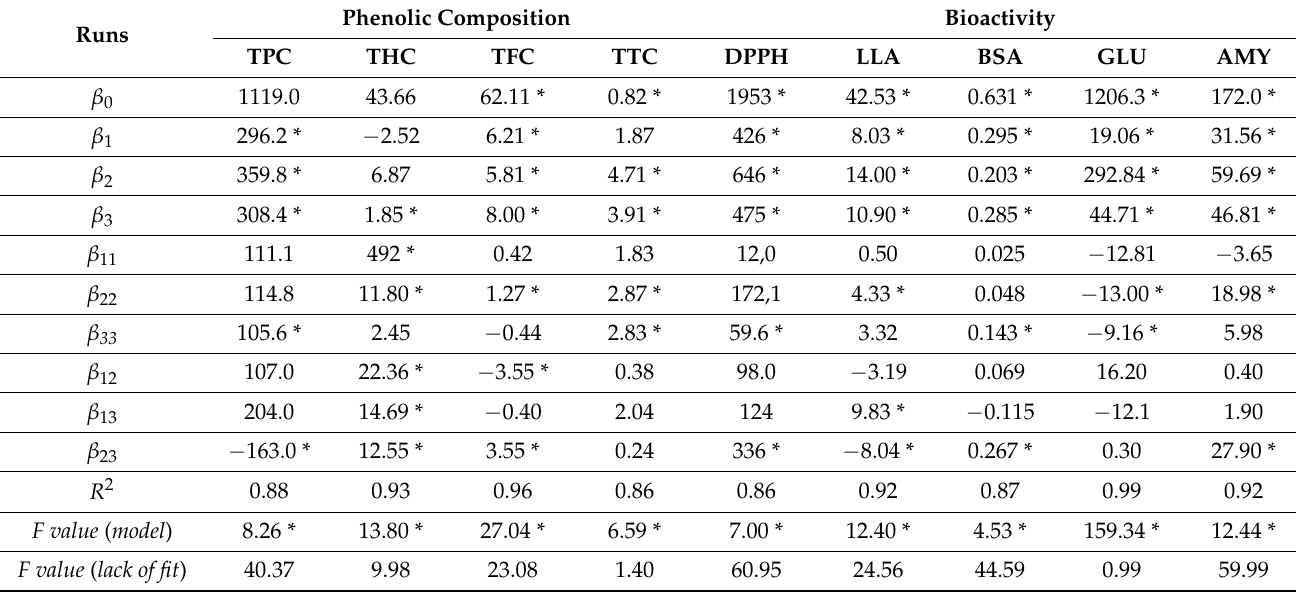
Table 3. Regression coefficient ( β ), coefficient of determination ( R 2 ) and F-test value of the Central Composite Design model for phenolic composition and bioactivity of grape pomace infusions. β 1 = regression coefficient of infusion time, β 2 = regression coefficient of water to solid ratio, and β 3 = regression coefficient of infusion temperature. p -values lower than 0.05 are statistically significant and indicated with the symbol